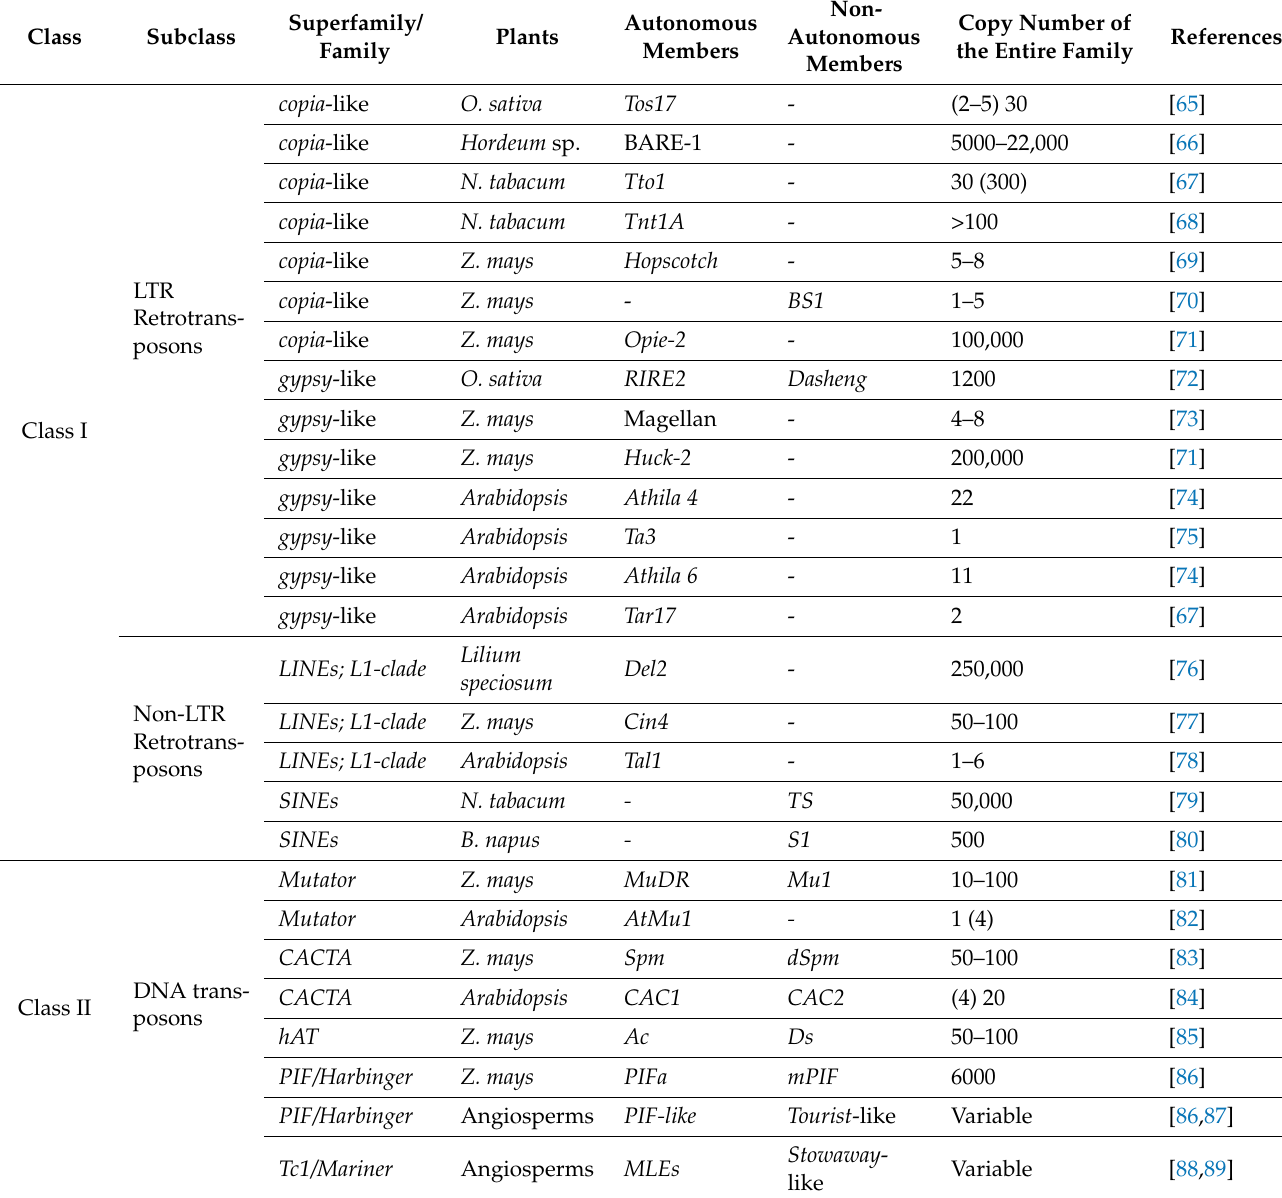
Table 1. Class- and family-wise examples of transposable elements (TEs) in different plant species. The table was adapted and recreated from Feschotte et al. [64], with copyright permission from the Licensor Springer Nature (Nature